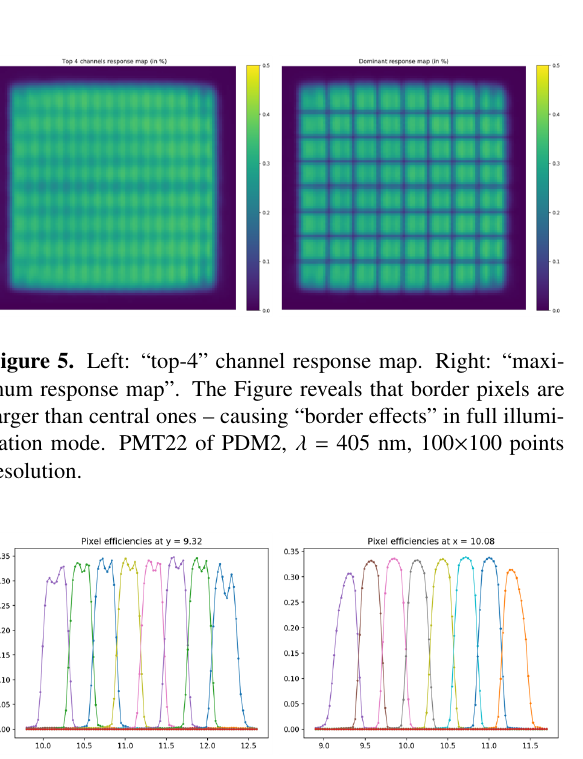
Figure 4. Full scan of PDM 3, at a wavelength of 375 nm